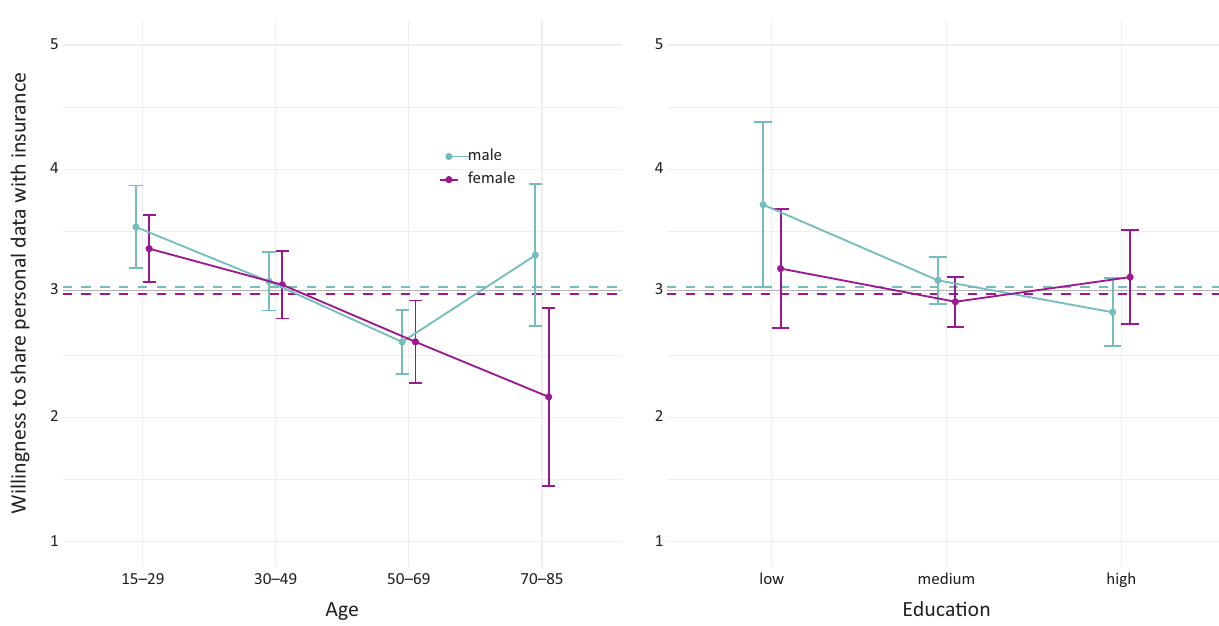
Figure 5. Willingness to share personal data with insurance company: Mean scores by gender, age, and education. Notes: Vertical bars represent 95% confidence intervals; horizontal lines represent overall (solid) and group means (dashed); Y‐axis indicates means on a continuous scale (1 = do not agree at all to 5 = completely agree ); N =